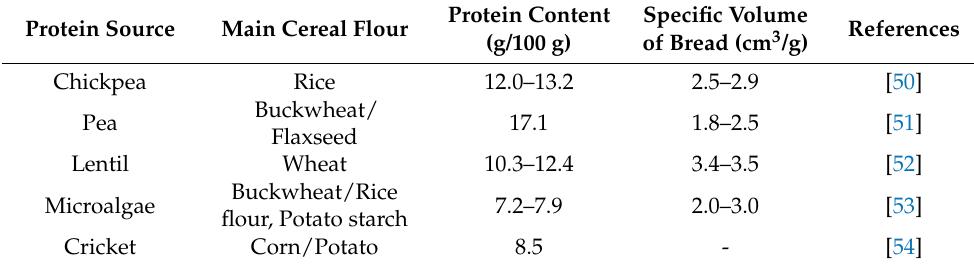
Table 1. Recent examples of cereal-based high-protein, low-carb breads.